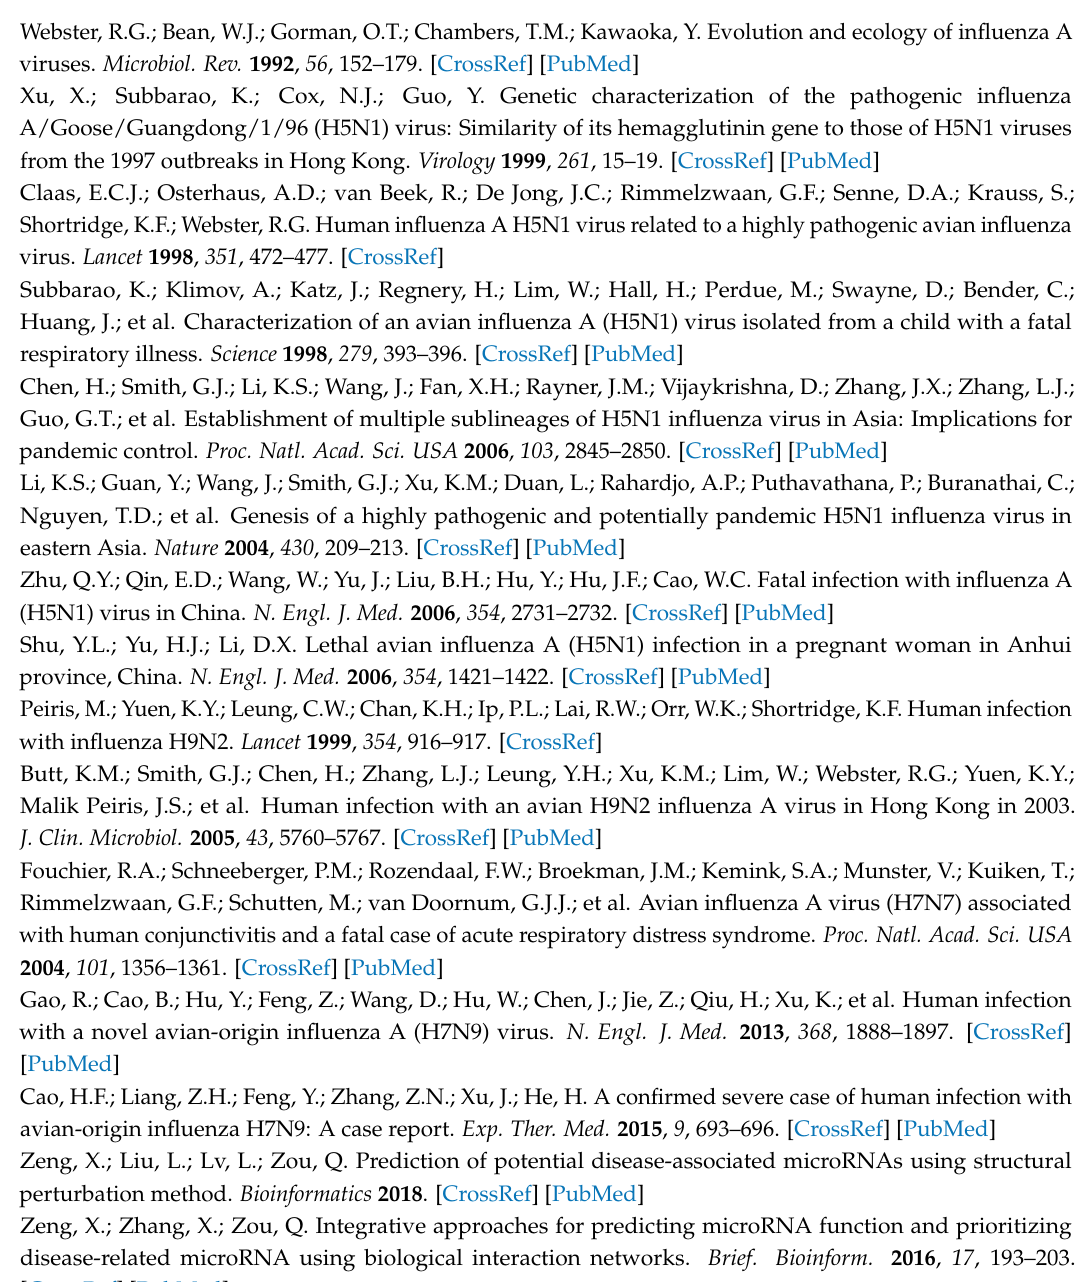
Supplementary Materials: Table S1: AIV Strains in the final dataset, Table S2: Human-origin AIVs clustered by the MDS